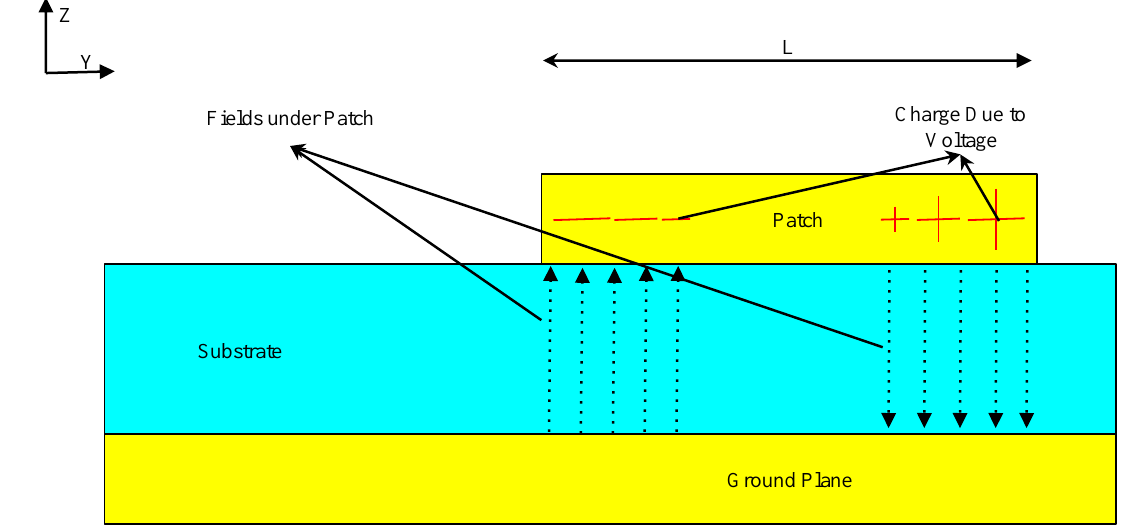
Figure 3. The Operation of Patch